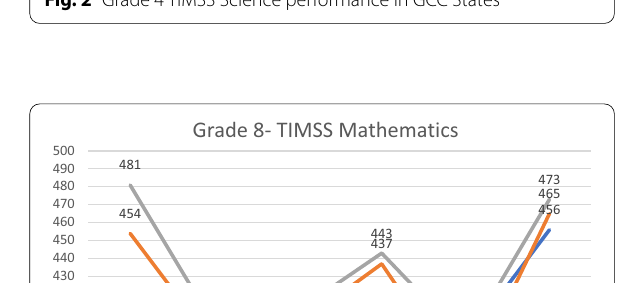
Fig. 1 Grade 4 TIMSS Mathematics performance in GCC States